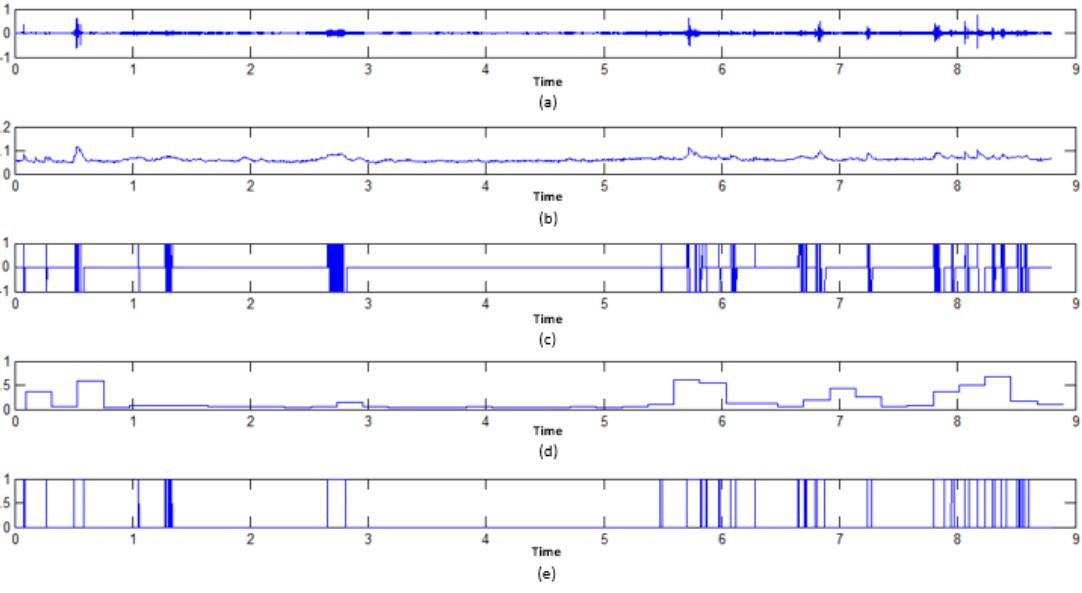
Figure 20. Flow example of a 10 s soundtrack with correspondent signals achieved by the proposed data collector: ( a ) A down-sampled sound signal; ( b ) envelope magnitude; ( c ) slope sign; ( d ) maximum amplitude; ( e ) duration of detection.